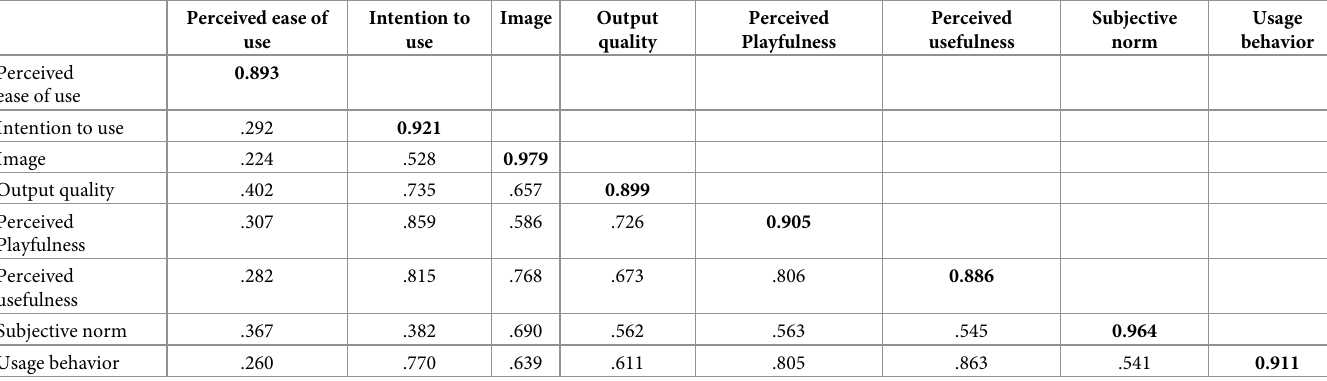
Table 6. Discriminant validity of the latent constructs for cognitive exergames.